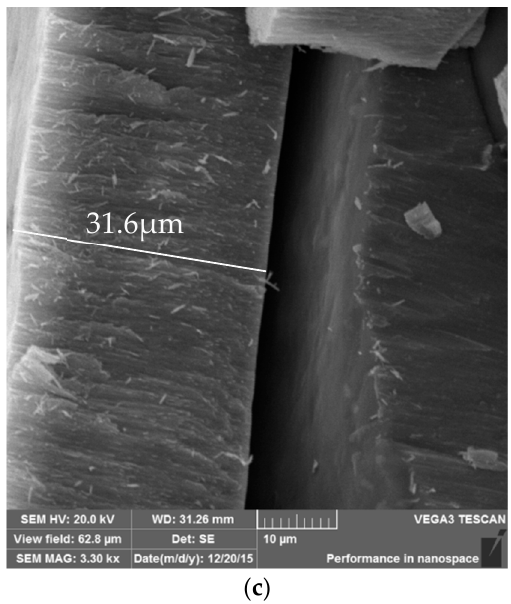
Figure 3. Cross-sectional electron microscopy photographs of the modified alumina film at different deposition times ( a ) 0 min; ( b ) 10 min; and ( c ) 30 min.